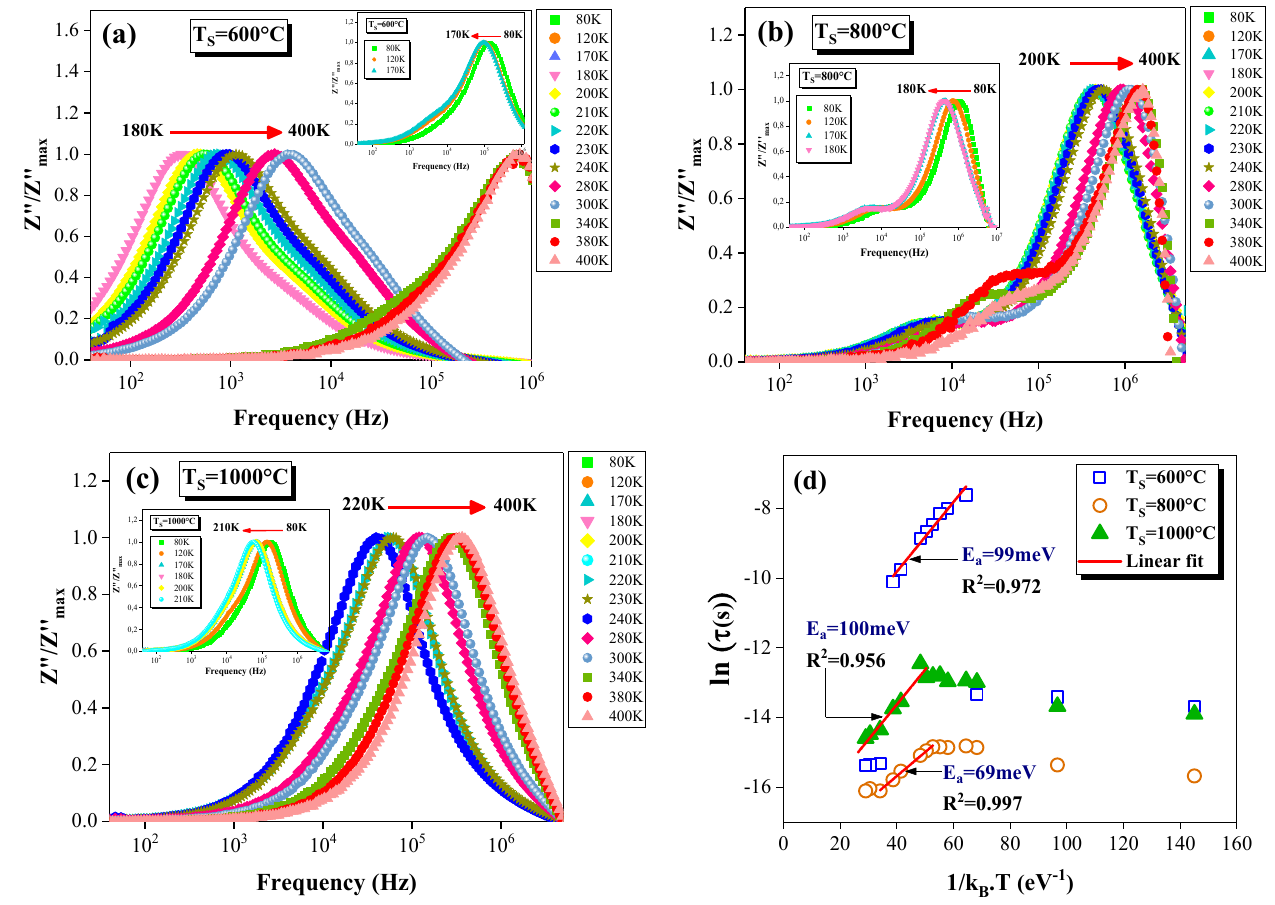
Figure 3. Frequency dependence of the normalized imaginary part of the impedance (Z’’) at different temperatures for La 0.9 Sr 0.1 MnO 3 compound sintered at 600 °C ( a ), 800 °C ( b ), and 1000 °C ( c ). Plot of ln( τ ) versus the inverse of temperature (1/k B ×T) of the La 0.9 Sr 0.1 MnO 3 compound at different sintering temperatures ( d ).